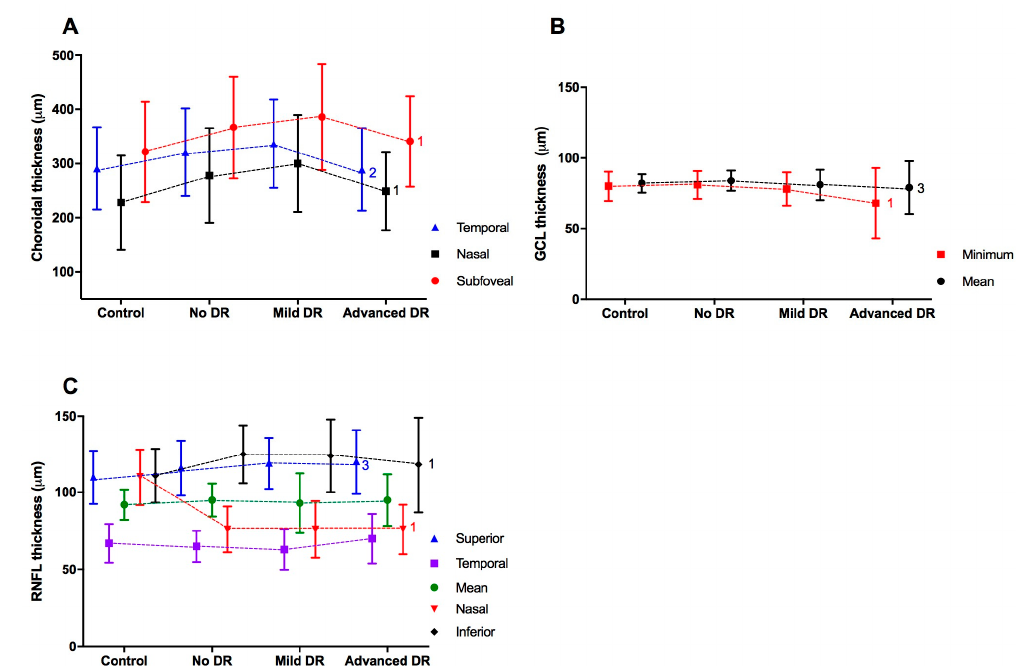
Figure 3. The thickness of the ophthalmological variables according to the diabetic retinopathy (DR) group. ( A ) Choroidal thickness. ( B ) Ganglion cell layer (GCL). ( C ) Retinal Nerve Fibre Layer thickness (RNFL). Di ff erences between groups (control, no DR, Mild DR, and advanced DR) were evaluated by analysis of variance, and the p values were corrected using the post hoc Tukey test; 1, p < 0.001; 2, p < 0.01; 3, p < 0.05. In the figure, the mean and standard deviation. Control group n = 69, no DR n = 139, Mild DR n = 74 and Advanced DR n =